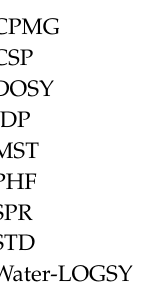
Figure S1: 2D [ 1 H- 15 N] SF-HMQC spectra of 15 N-labelled tau K18 M in the presence and absence of literature compounds, Figure S2: 2D [1H-13C] HSQC spectra of 13C,15N-labelled tau K18M in the presence and absence of compound 6, Figure S3: Kinetic SPR binding curves and steady-state a ffi nity graphs for literature compounds, Figure S4: MST dose-response data for literature compounds to dye-labelled tau K18M, Figure S5: Investigation of potential Cl-NQTrp covalent adducts to tau K18M using MS and NMR, Figure S6: 2D [1H-15N] SF-HMQC spectra of 15N tau K18M in the presence of 2 mM Cl-NQTrp at di ff erent concentrations of NaCl., Figure S7. The observed CSPs for 15N tau K18M in the presence of ethanolamine,